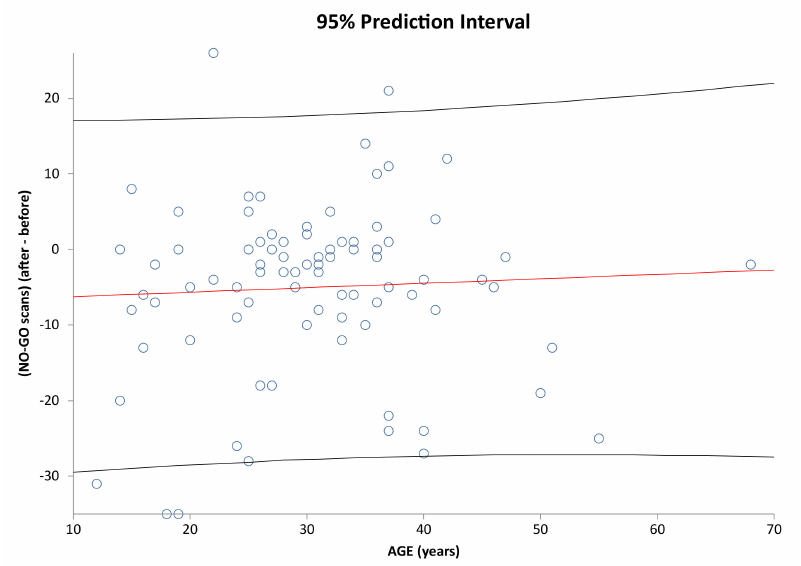
Figure 9. Prediction interval and linear regression line for No-go scans (after-before) vs. Age in the investigated sample (r = 0.0507; p = 0.6433). Regression line and 95% prediction interval are denoted as in Figure 7.